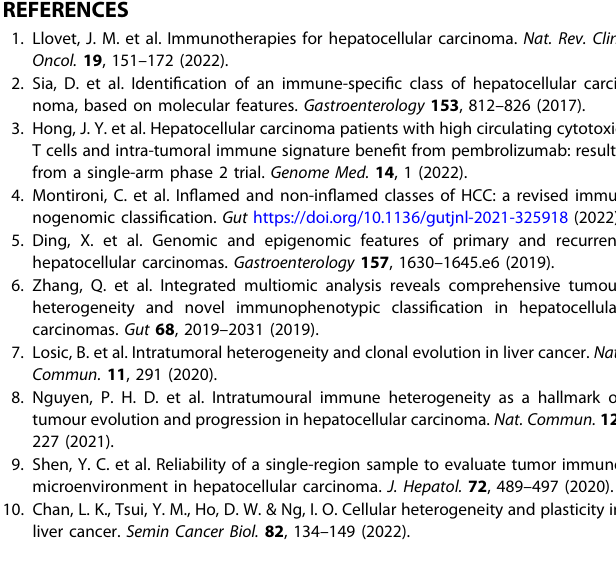
Fig. 1 An optimized signature for immune evaluation through introducing multi-regional sequencing data into signature construction. a Schematic illustration of the study design. b The distribution of the signature scores of multi-regional tumor samples from Renji (upper) and GSE136711 (lower) cohort classi fi ed by 20-gene signature. Tumors were divided into in fl amed and non-in fl amed classes based on tertiles. Gray nodes represent the tumor samples from the same patient classi fi ed into a concordant classi fi cation. Red nodes represent the tumor samples from the same patient classi fi ed into discordant classi fi cations. c The proportion of concordant and discordant classi fi cation in Renji and GSE136711 cohort classi fi ed by 20-gene signature. A concordant tumor means that the multi-region samples in this tumor all belong to a single class (in fl amed or non-in fl amed class), while a discordant tumor means that multi-region samples in this tumor belong to both in fl amed and non-in fl amed class. d The distribution of the signature scores of multi-regional tumor samples from Renji and GSE136711 cohort classi fi ed by optimized 29-gene signature. e The proportion of concordant and discordant classi fi cation in Renji and GSE136711 cohort classi fi ed by 29- gene signature. f Expression pattern of genes in the 29-gene signature in Renji cohort. g Correlation analysis of signature scores between